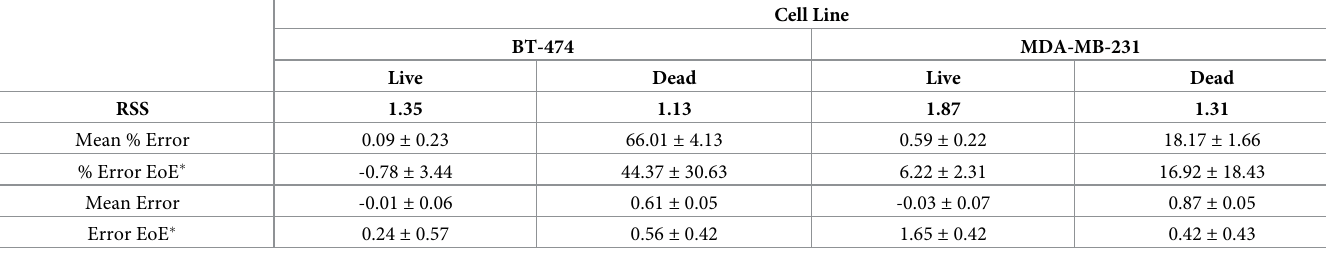
Table 4. Evaluation of fitting quality with selected model for both cell